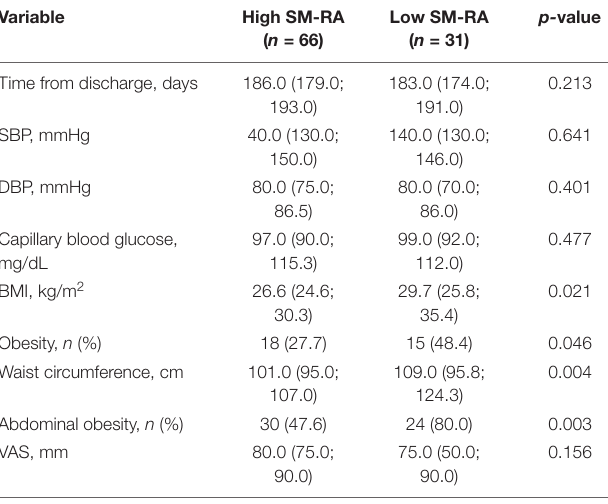
TABLE 1 | Comparison between patients with (low SM-RA) or without (high SM-RA) myosteatosis during acute COVID-19. Variable